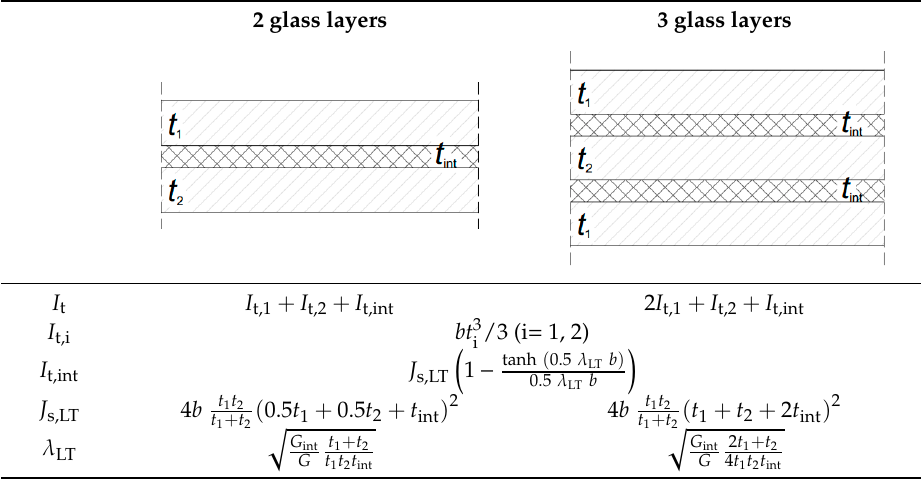
Table 2. Torsional equivalent section properties for laminated glass members, according to [25]. Table 1. Flexural equivalent section properties for laminated glass beams in LTB, according to [25].